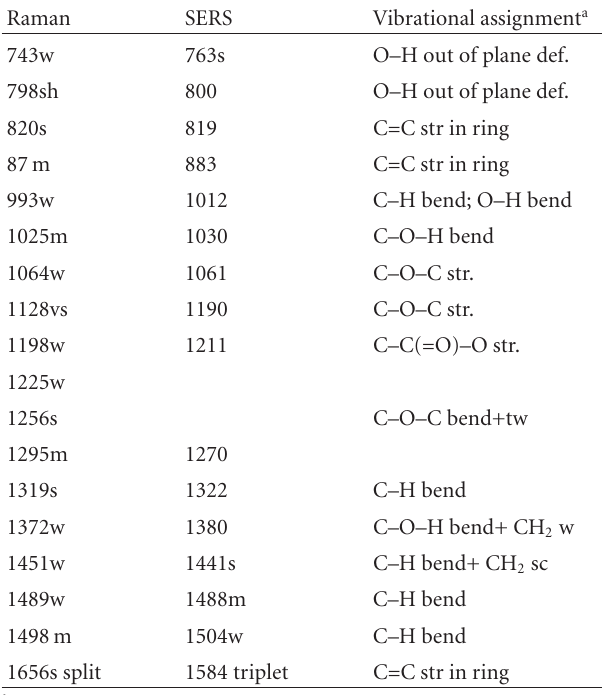
Table 1: Raman and SERS bands of L-ascorbic acid and